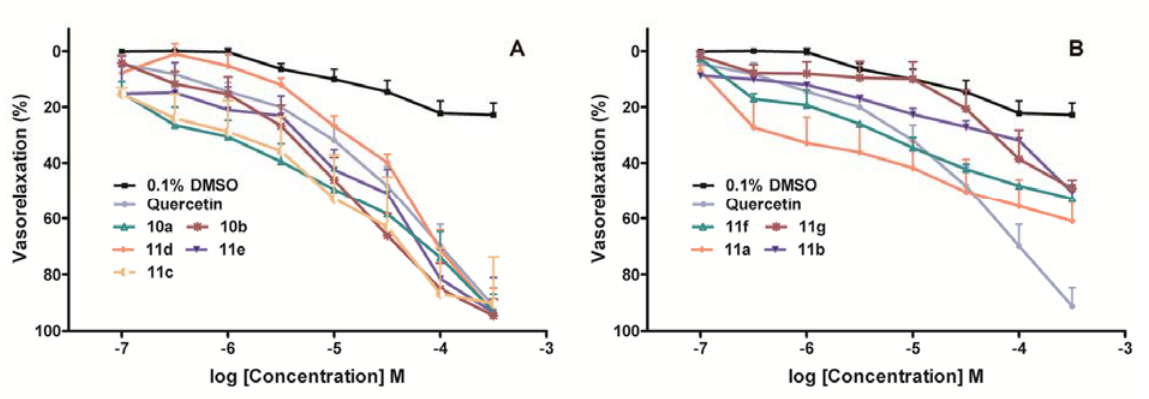
Figure 3. Effects of flavonoids on relaxation in aortic rings with endothelium pre-contracted with 1 μ M phenylephrine. Flavonoids were added cumulatively to achieve the appropriate concentrations. Results are expressed as means ± standard error of mean in terms of percentage relaxation of the contraction to PE (n = 3 ~ 4). (A) Flavonoids with highly vasorelaxation effect; (B) Flavonoids with weakly vasorelaxation effect.